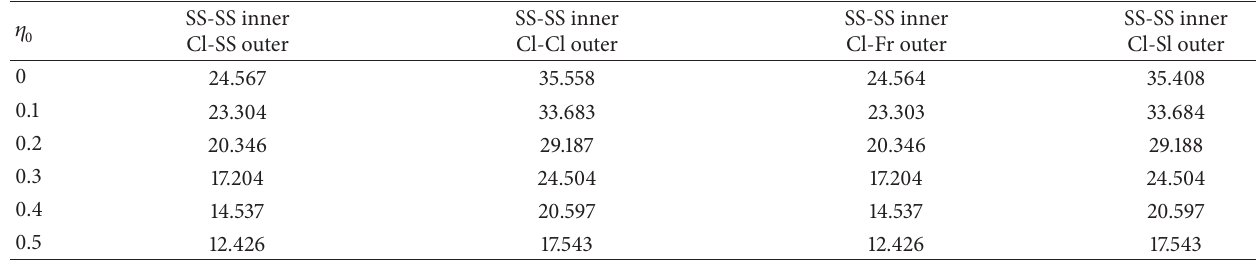
Table 12: Fundamental frequency of vibration 𝜆 1 of DWCNTs with different boundary conditions between inner and outer tubes and for [ 0.1–0.5 ] . 𝜂 0